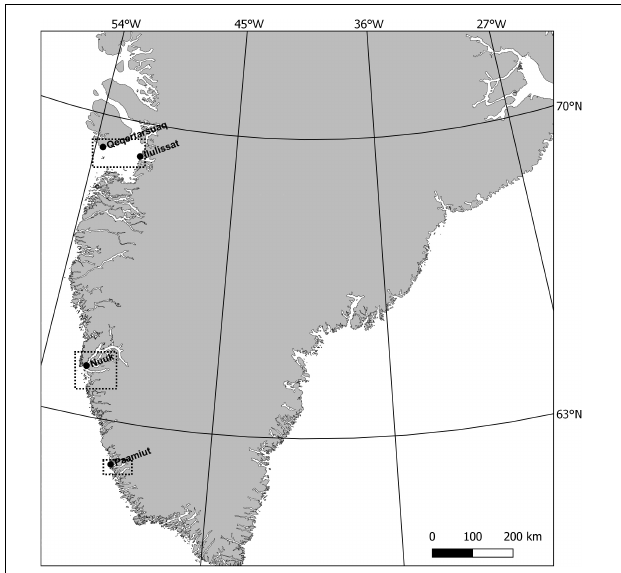
FIGURE 1 | Sampling area where black boxes indicate the catch areas.